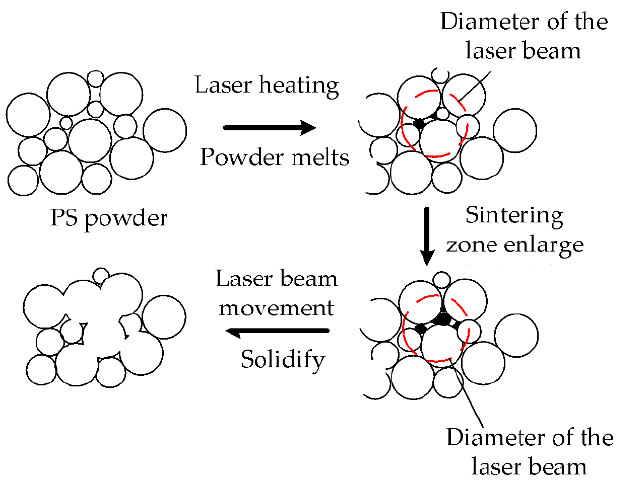
Figure 9. Sintering mechanism of SLS process.